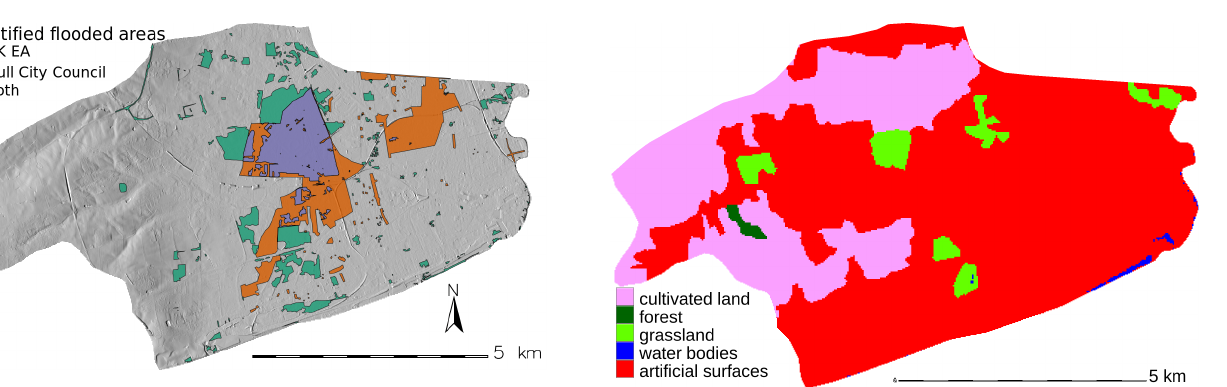
Figure 12. Map of the land cover classes in Hull from GLC30 (Chen et al.,